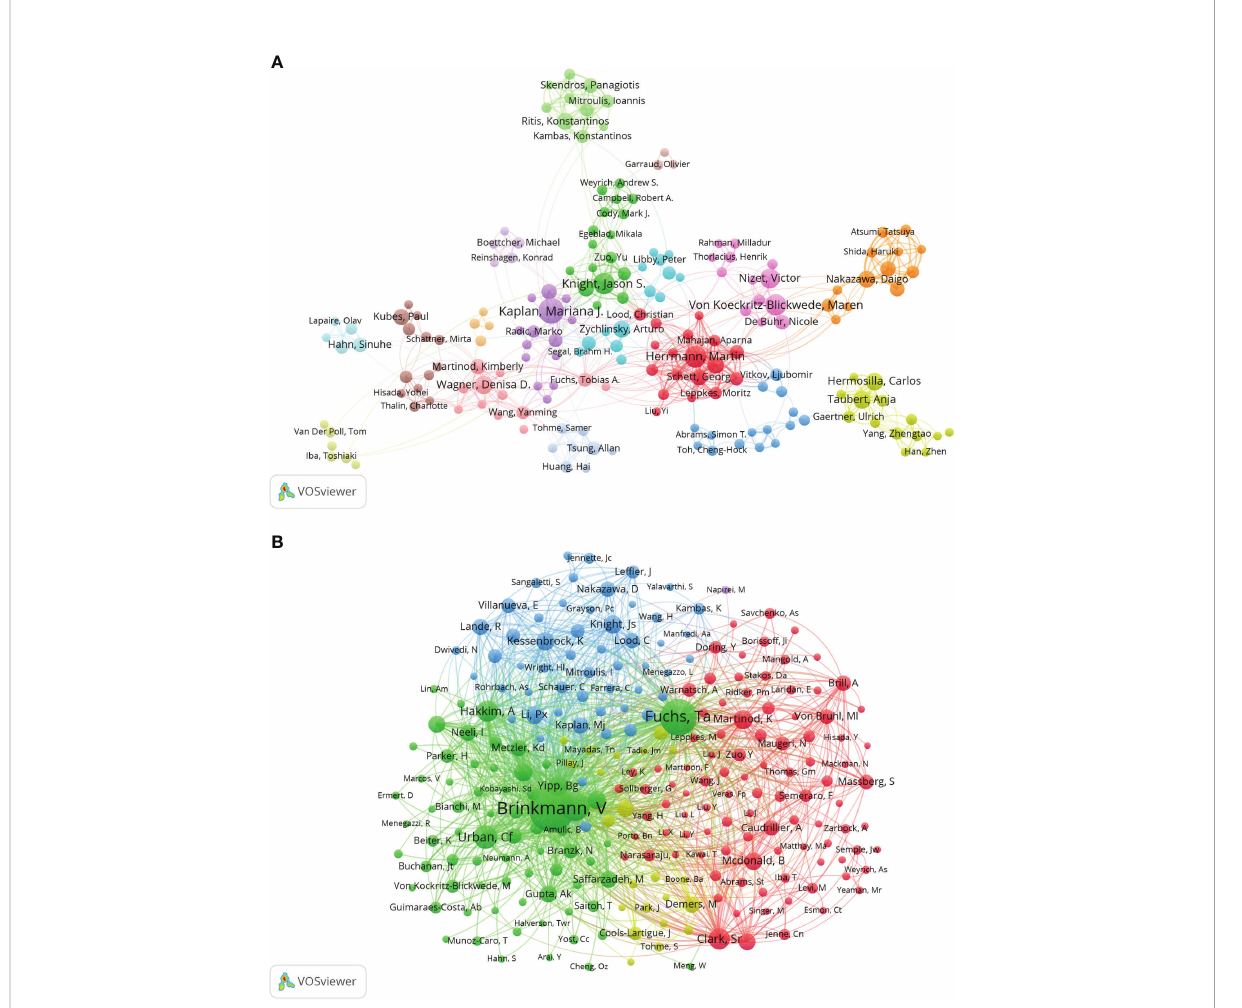
FIGURE 4 Analysis of NETs-related author. (A) Collaborative network visualization of authors in VOSviewer. The fi gure shows the authors with more than 8 documents. The nodes in different colors represent the authors in different clusters, and the size of the nodes indicates the frequency of their occurrence. (B) Analysis of collaborative network visualization of authors ’ citations in VOSviewer. The size of the nodes indicates the frequency of their occurrence.